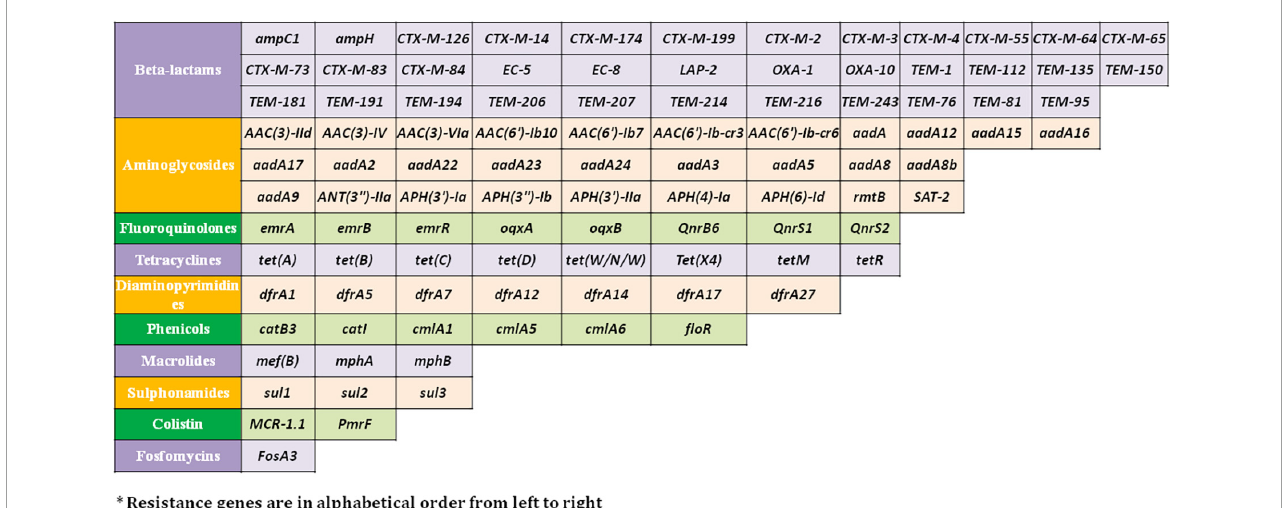
FIGURE2 Resistance genes ∗ against major antimicrobial classes identified in the E. fergusonii genomes.